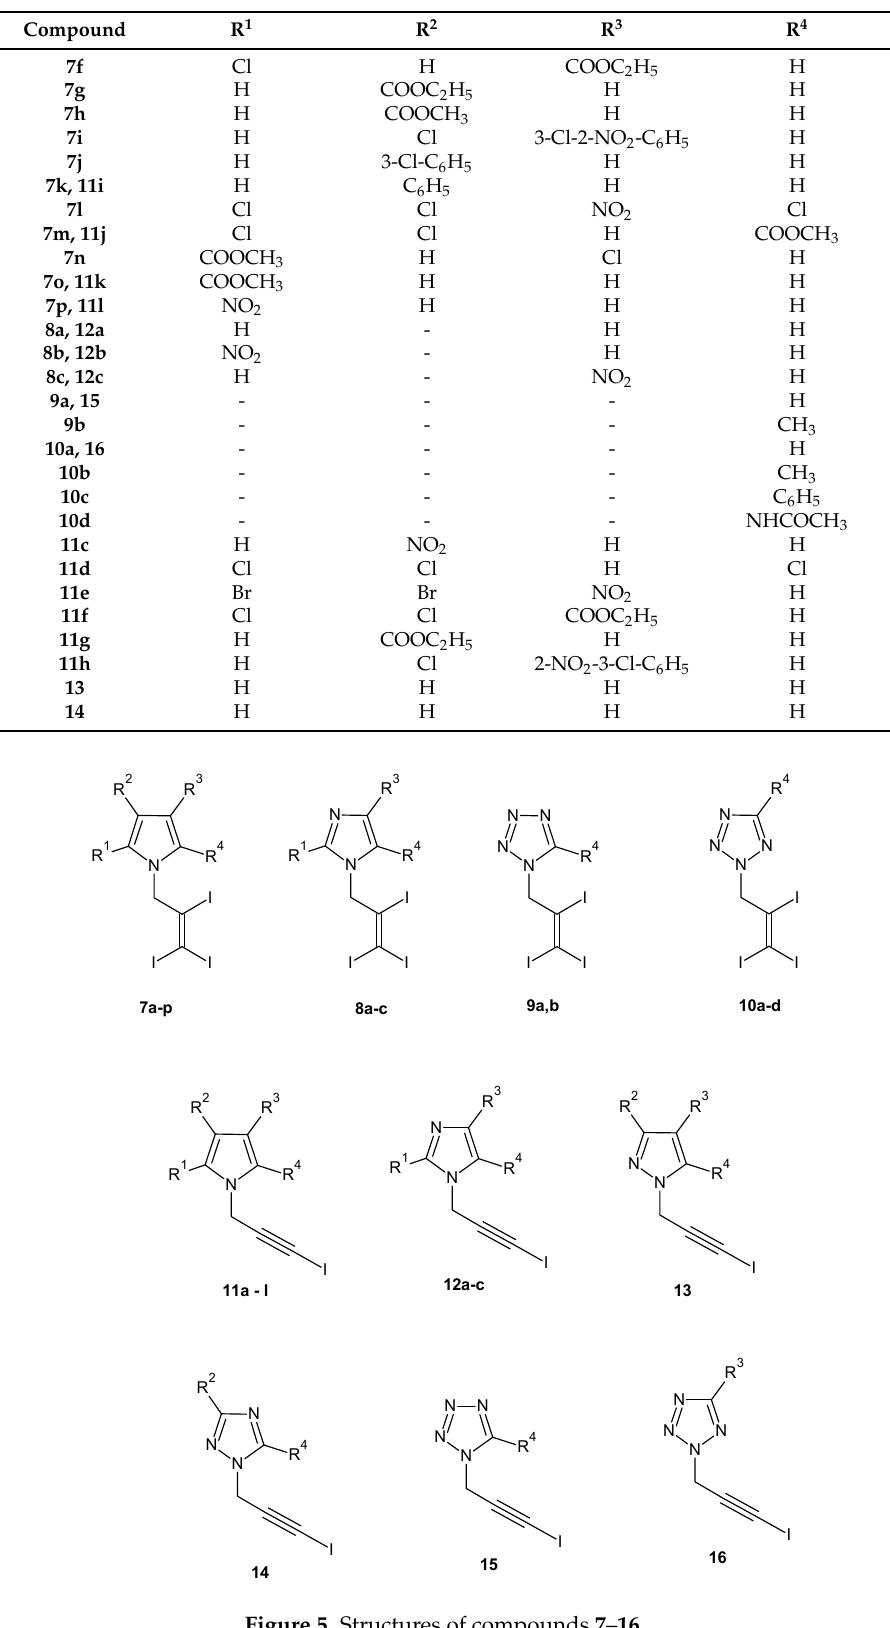
Figure 5. Structures of compounds 7 – 16 .